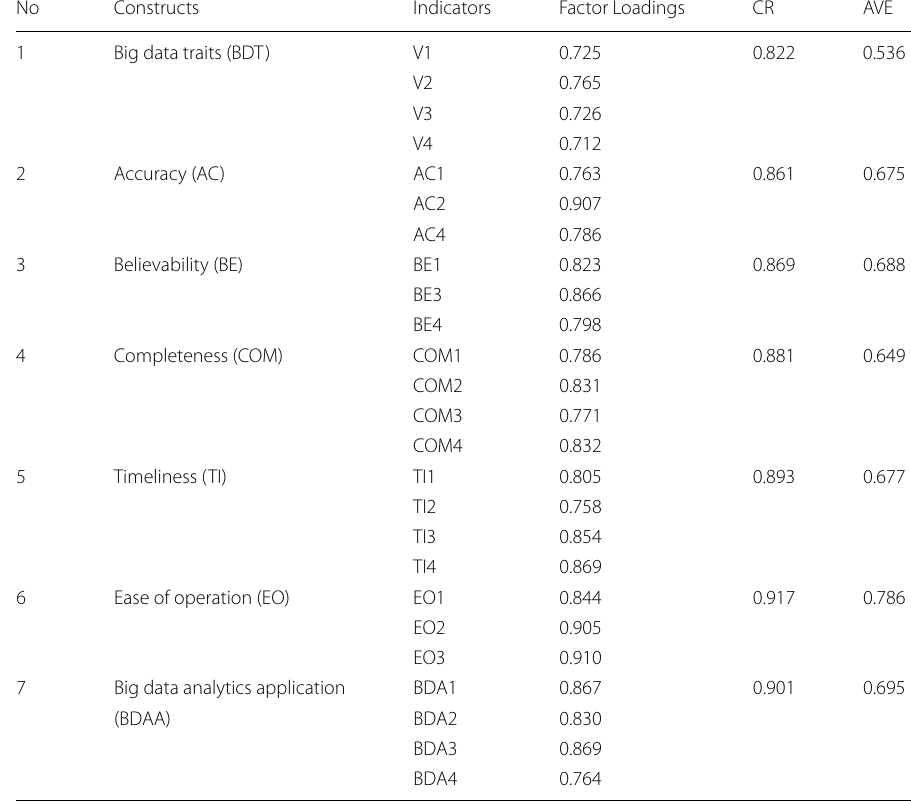
Table 3 Convergent validity results